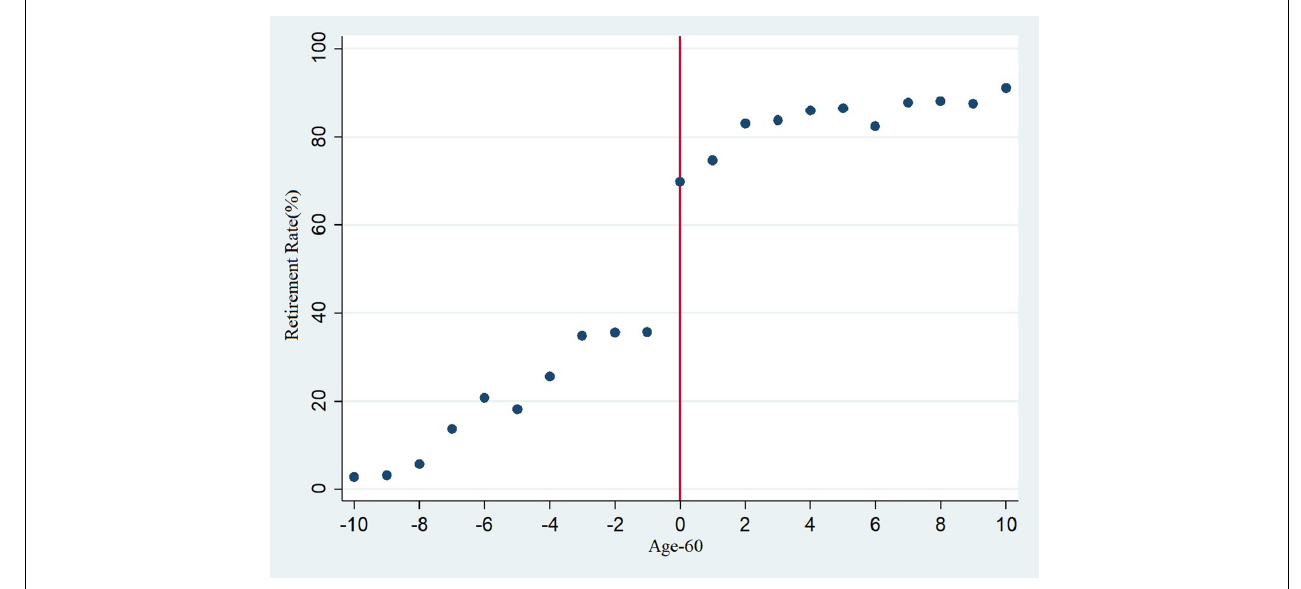
FIGURE 1 | Age and retirement rate.